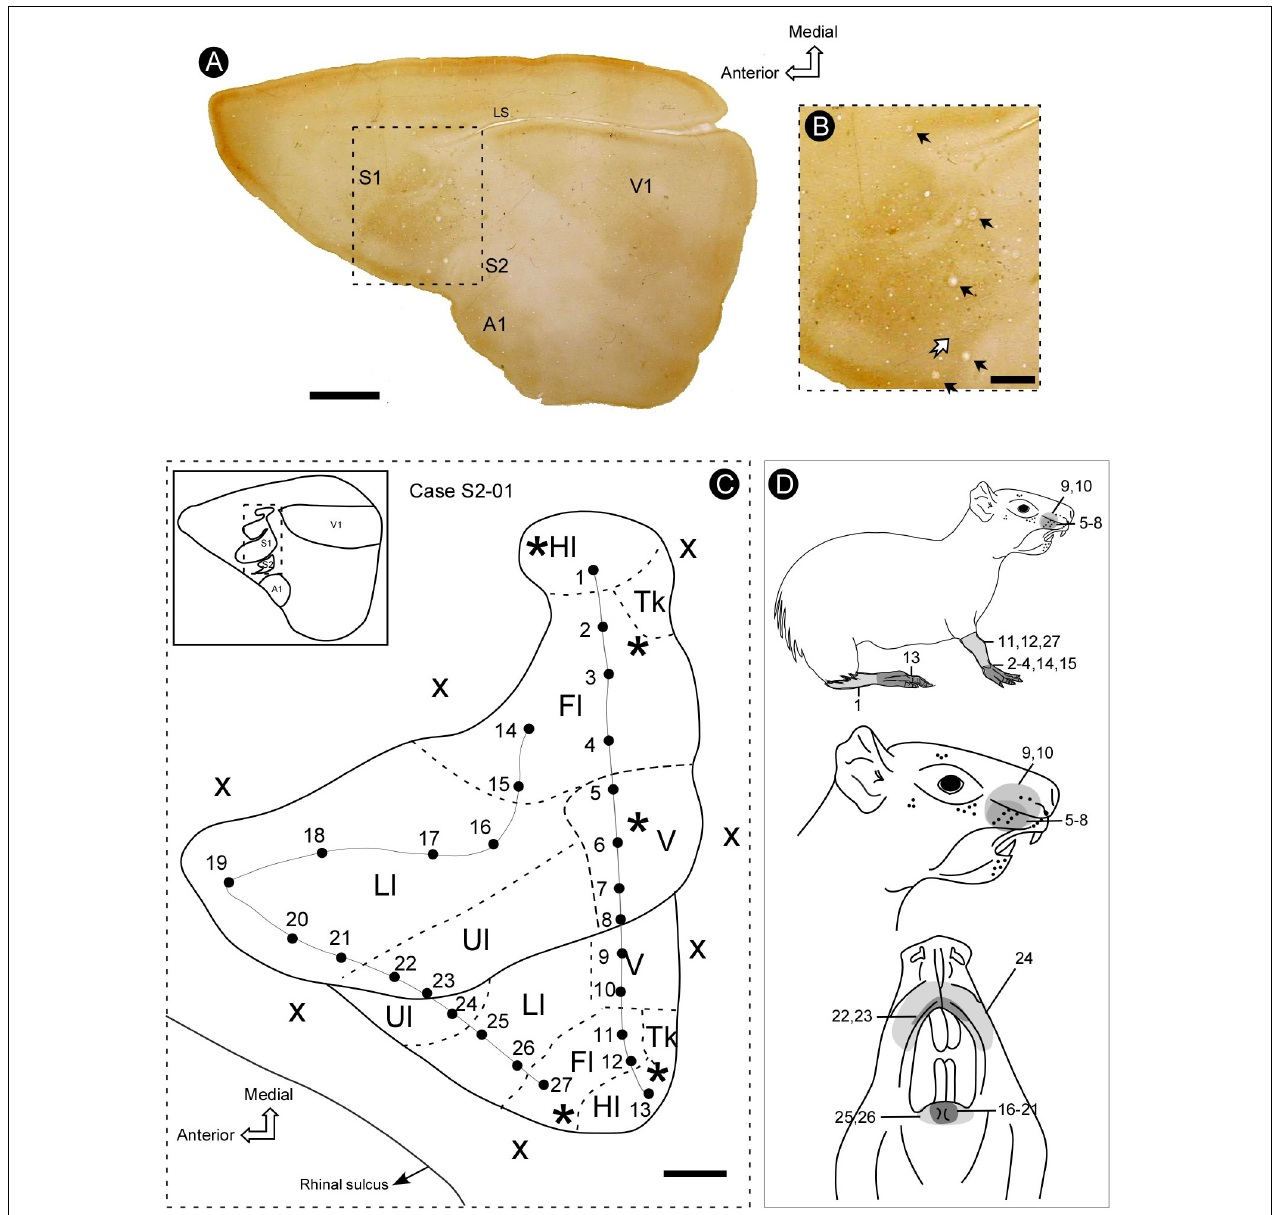
FIGURE 2 | Topographic organization of primary (S1) and secondary (S2) somatosensory areas of the agouti. (A) Section of the flattened cortex, processed for cytochrome oxidase (CO) histochemistry, revealing the location of primary somatosensory (S1), auditory (A1), and visual (V1) areas, as well as the secondary somatosensory cortex (S2). (B) Micrograph amplification showing S1 and S2 (medial portion) (dotted rectangle in A ). Electrolytic lesions are indicated by black arrows. The limit between S1 and S2 is defined as a narrow strip of less reactive tissue (white arrow). (C) Topographic map of S1 and S2 reconstructed from recording sites. The limits of distinct body representations are delimited by dashed lines. Continuous lines indicate the reversal of receptive field sequences across S1 and S2 (penetrations 1–13 and 14–27). (D) Drawing of the agouti’s body indicating the location of receptive fields illustrated in panel C . Grayscale codes indicate the difference in the size of receptive fields in both areas. Scale bars: A : 5 mm; B,C : 2 mm. Hl, hindlimb; Fl, forelimb; V, vibrissae; Ll, lower lip; Ul, upper lip; Tk, trunk; asterisk, electrolytic lesion; X, no response; LS, lateral